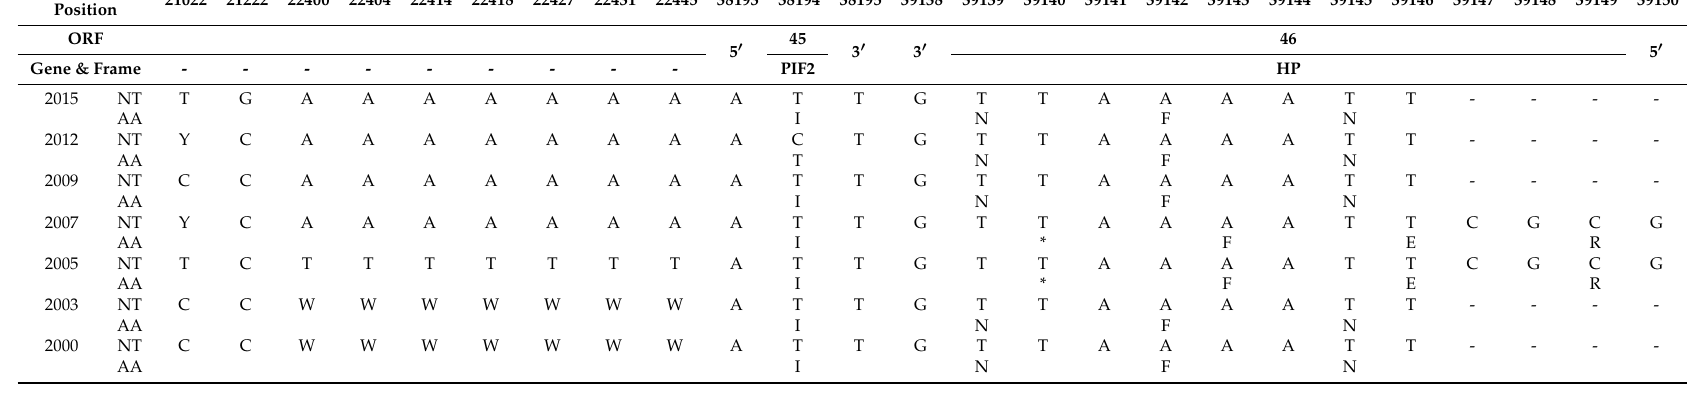
Table 1. Single nucleotide polymorphisms in Cryptophlebia leucotreta granulovirus South Africa sequences generated from samples collected in 2000, 2003, 2005, 2007, 2009, 2012 and 2015. Nucleotide